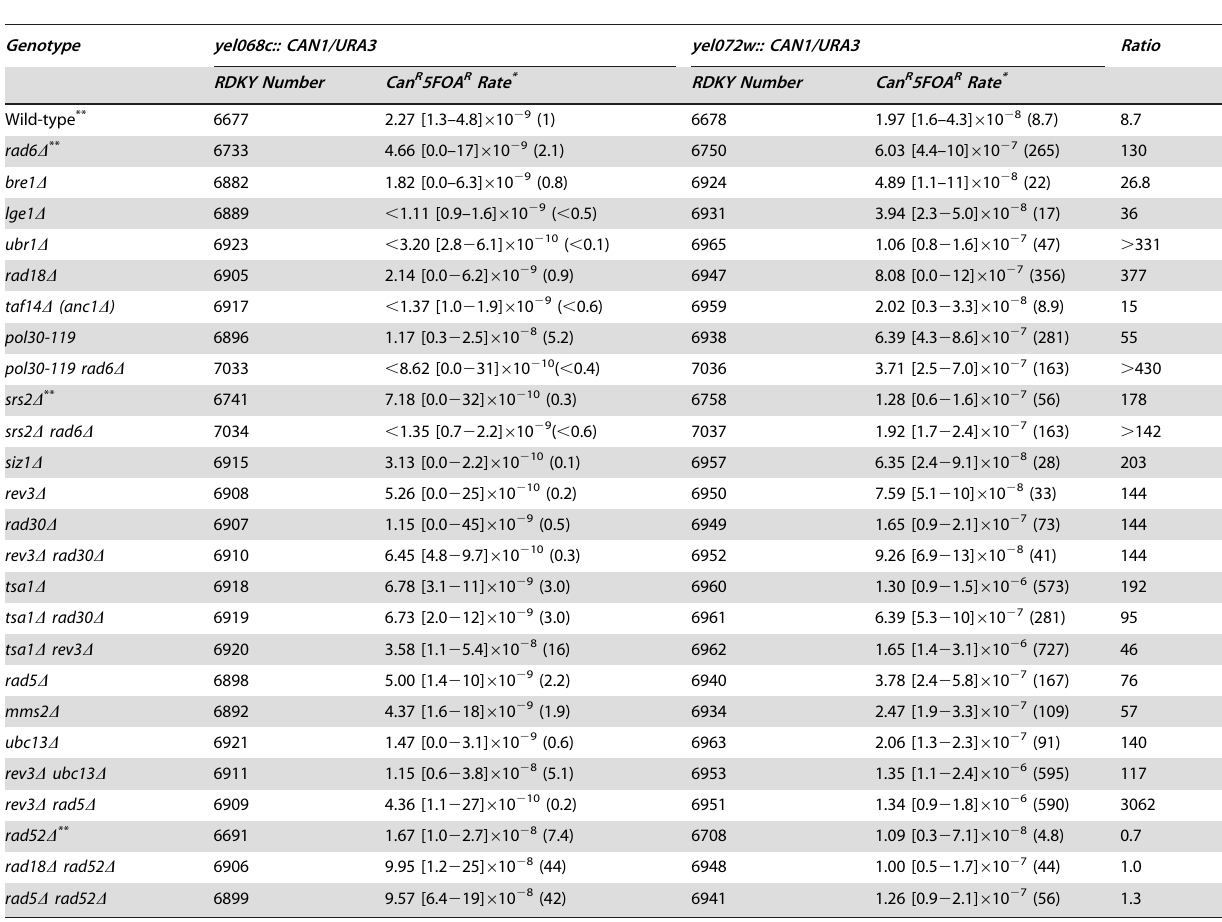
Table 2. Effects of mutations in PRR subpathways on duplication-mediated